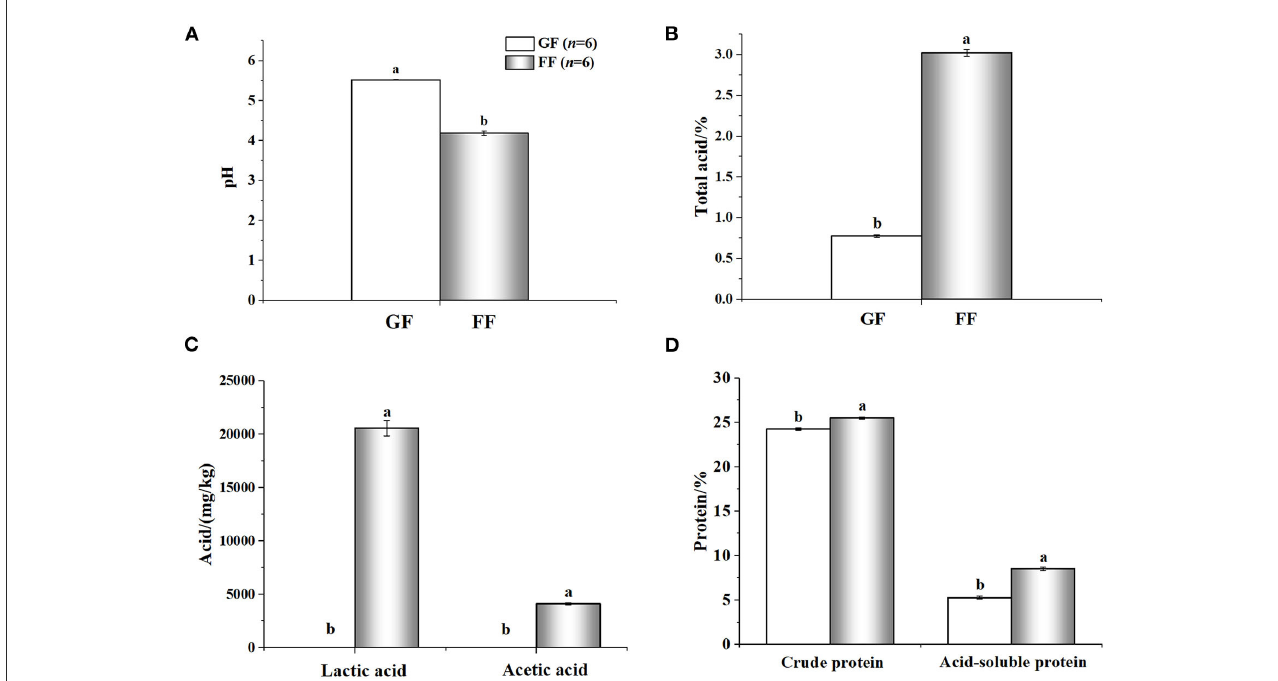
FIGURE3 Analyzed nutrient composition [ (A) : pH; (B) : total acid; (C) : acid; (D) : protein] of fermented feed and general feed. a,b Within the same parameter, superscripts with different letters indicate a significant difference ( p < 0.05); The rest are as above.